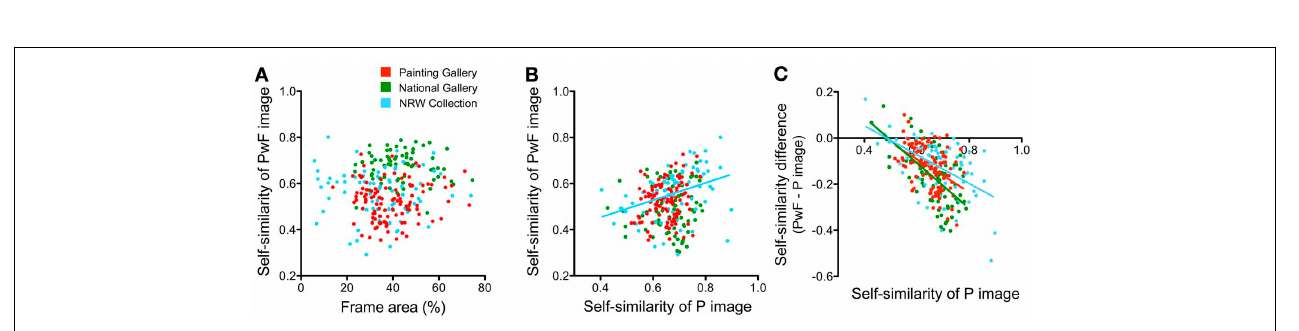
FIGURE 11 | Relations between frame area and self-similarity of paintings with or without frames. Scatter graphs of different combinations of the measures (see labeling of the x axis and y axis) are shown (A–C) . Each dot represents one painting. Colors represent the different museums, as